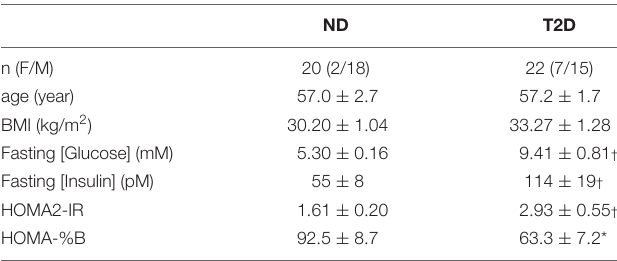
TABLE 1 | Subject